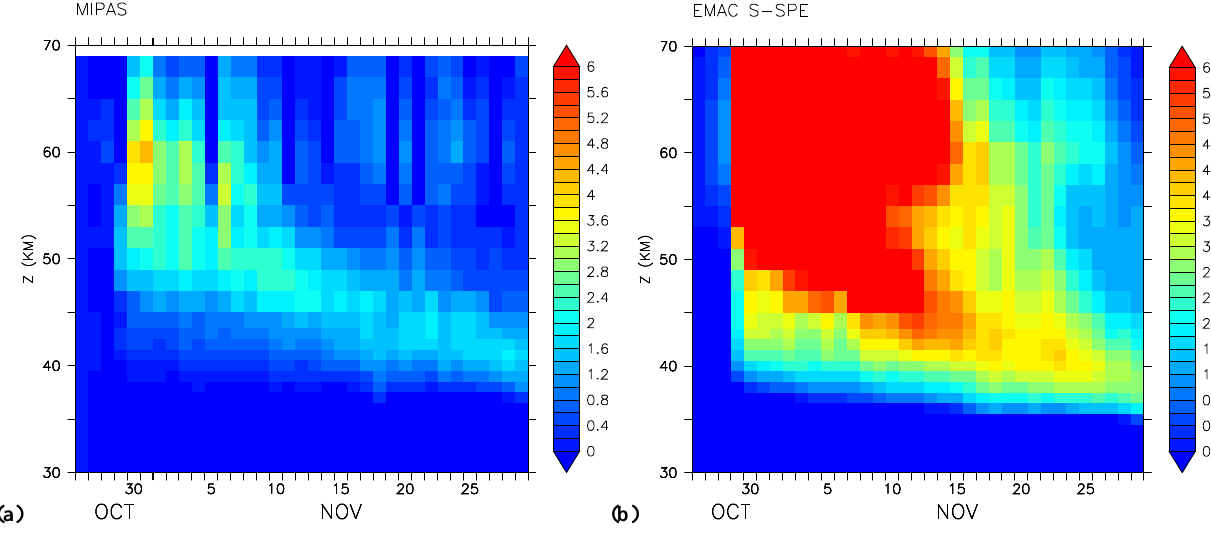
Fig. 5. Same as Fig. 4 but for N 2 O (ppbv).